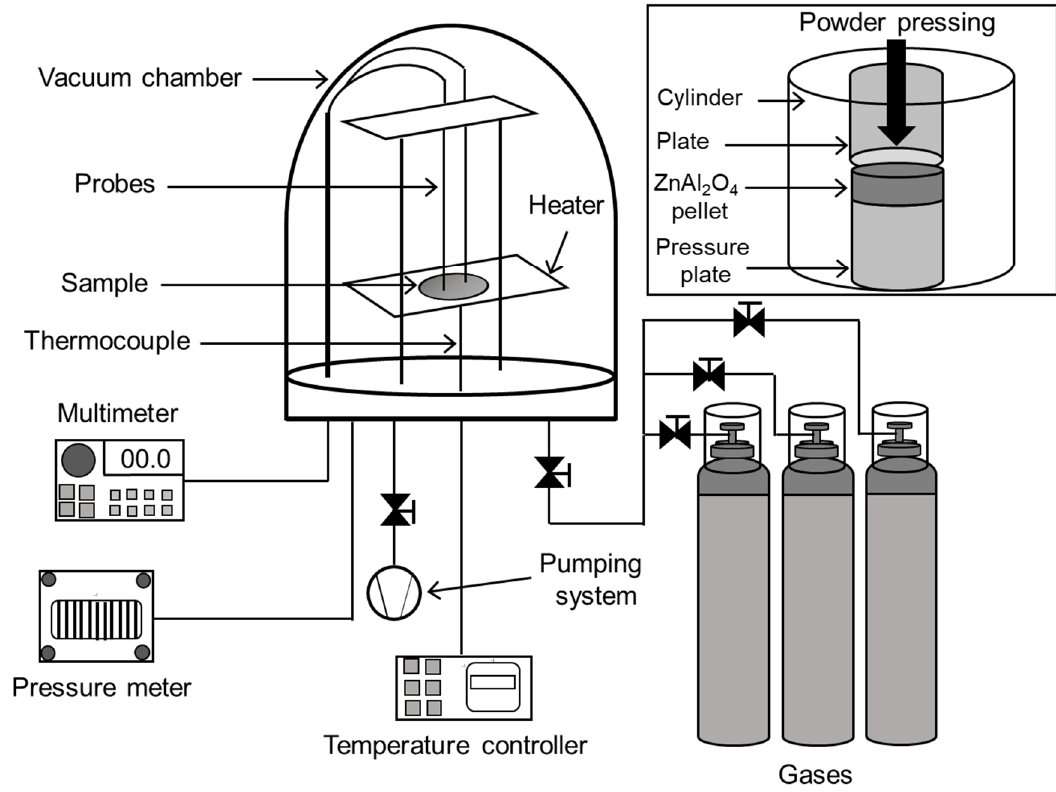
Figure 2. Experimental set-up for sensitivity tests in controlled atmospheres and temperatures. An illustration of the ZnAl 2 O 4 pellets fabrication is depicted in the right corner. illustration of the ZnAl 2 O 4 pellets fabrication is depicted in the right